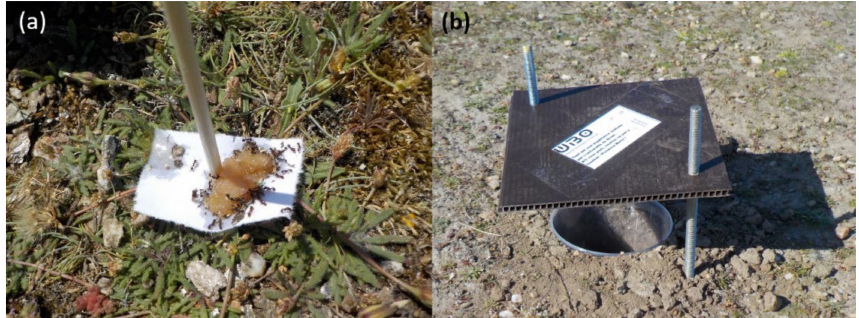
Figure 2. Example of ( a ) bait trap and ( b ) pitfall